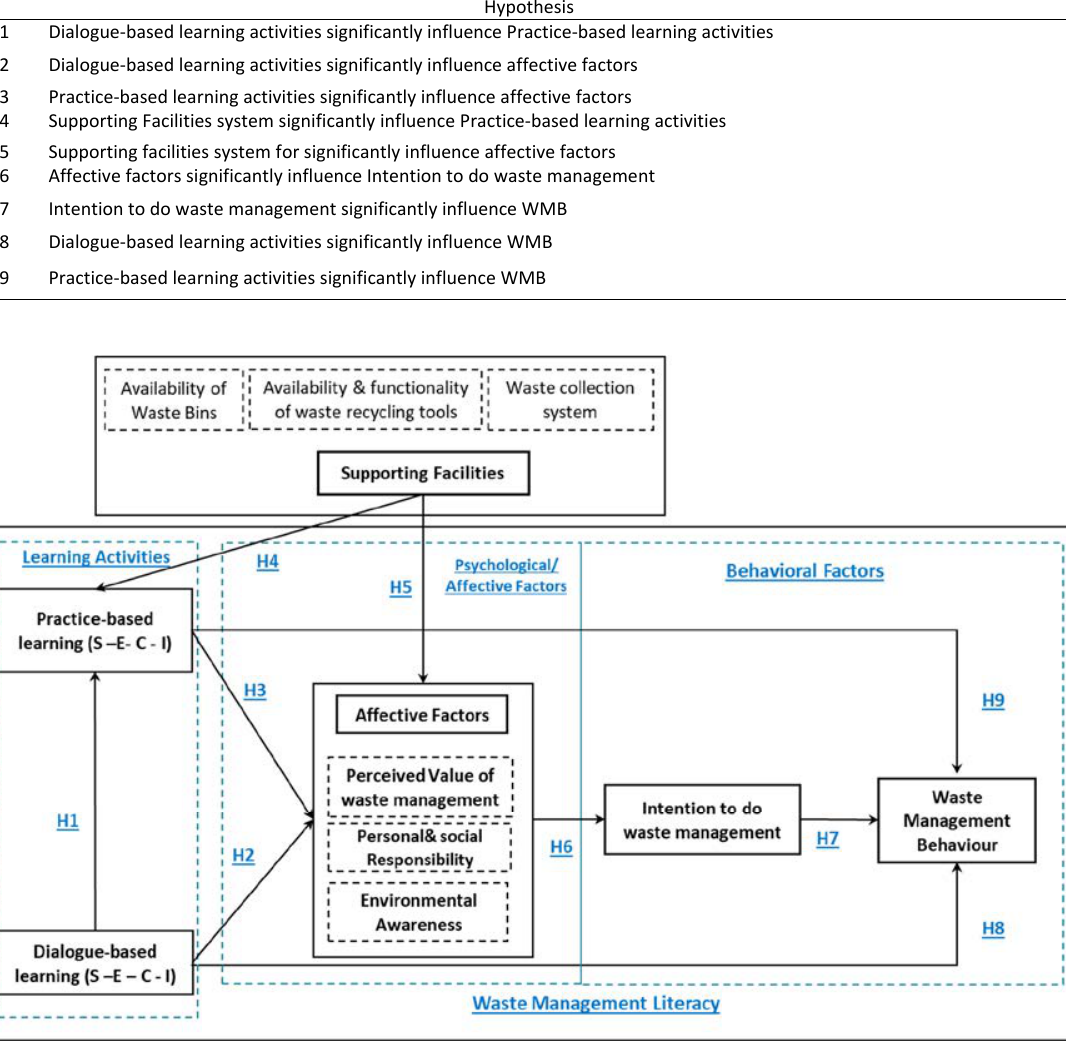
Fig. 4: Proposed model of the study